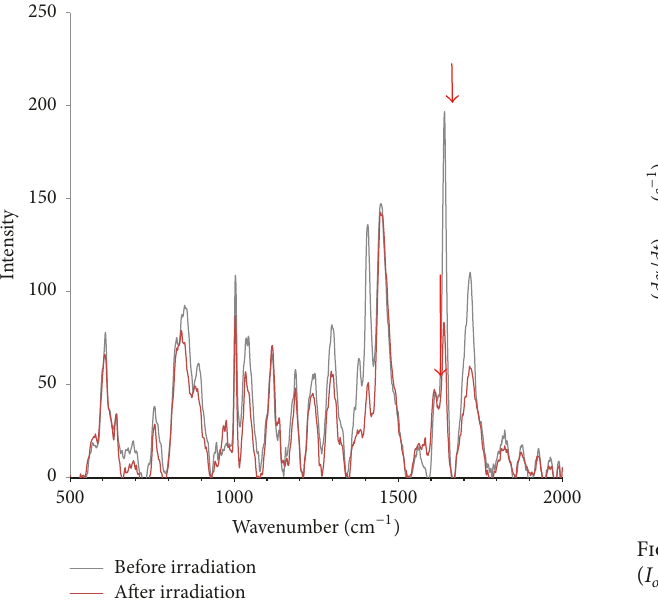
Figure 4: Representative Raman spectrum before and after irradia- tion with a LED light source.